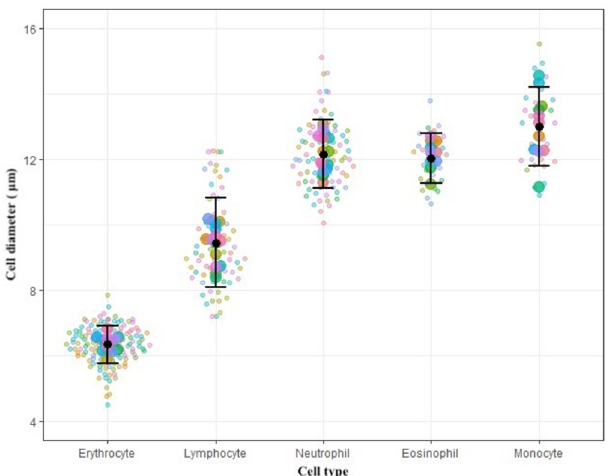
Fig 3. Individual cell diameters observed in neutrophils (n = 80), lymphocytes (n = 70), eosinophils (n = 28), monocytes (n = 30), and erythrocytes (n = 134). Each color represents an individual bat with larger dots depicting the mean for each cell type per bat. The error bars display the mean and 95% confidence intervals for each cell